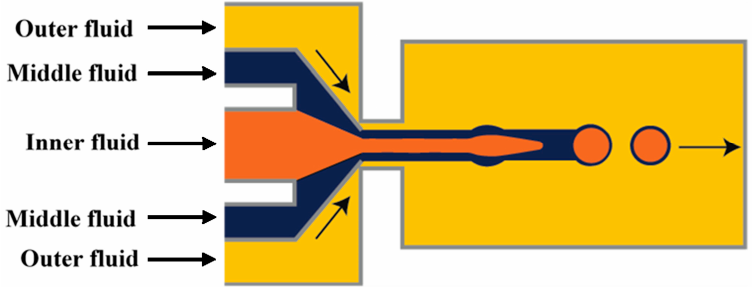
Figure 6. Schematic of production of double emulsion droplets in microfluidic flow focusing planar device with co-flow flow focusing geometry [118].